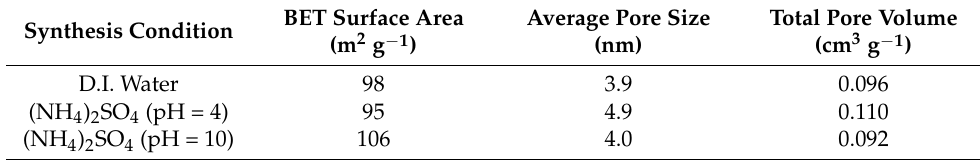
Figure 6. ( a ) N 2 adsorption–desorption isotherms ( b ) Barrett–Joyner–Halenda (BJH) pore-size dis- tribution of the Al@Al 2 O 3 core–shell samples obtained under various synthesis conditions. Table 2. Surface area, average pore size, and total pore volume of Al@Al 2 O 3